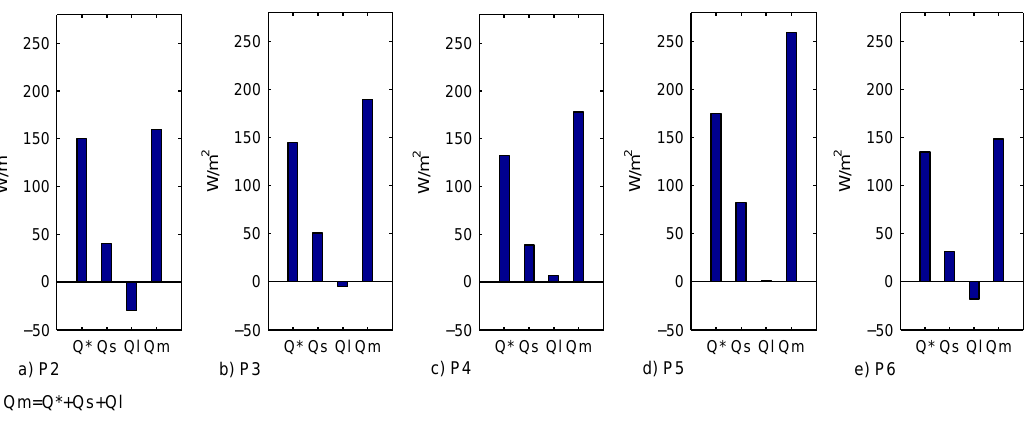
Fig. 8. Modeled mean energy fluxes for ablation periods P2 (a) , P3 (b) , P4 (c) , P5 (d) and P6 (e) : net radiation (Q*), sensible heat flux ( Q s ), latent heat flux ( Q l ), melt energy ( Q m ) during daytime (7:00a.m.–5:00p.m. Local time) for snow covered cells at the end of the respective ablation